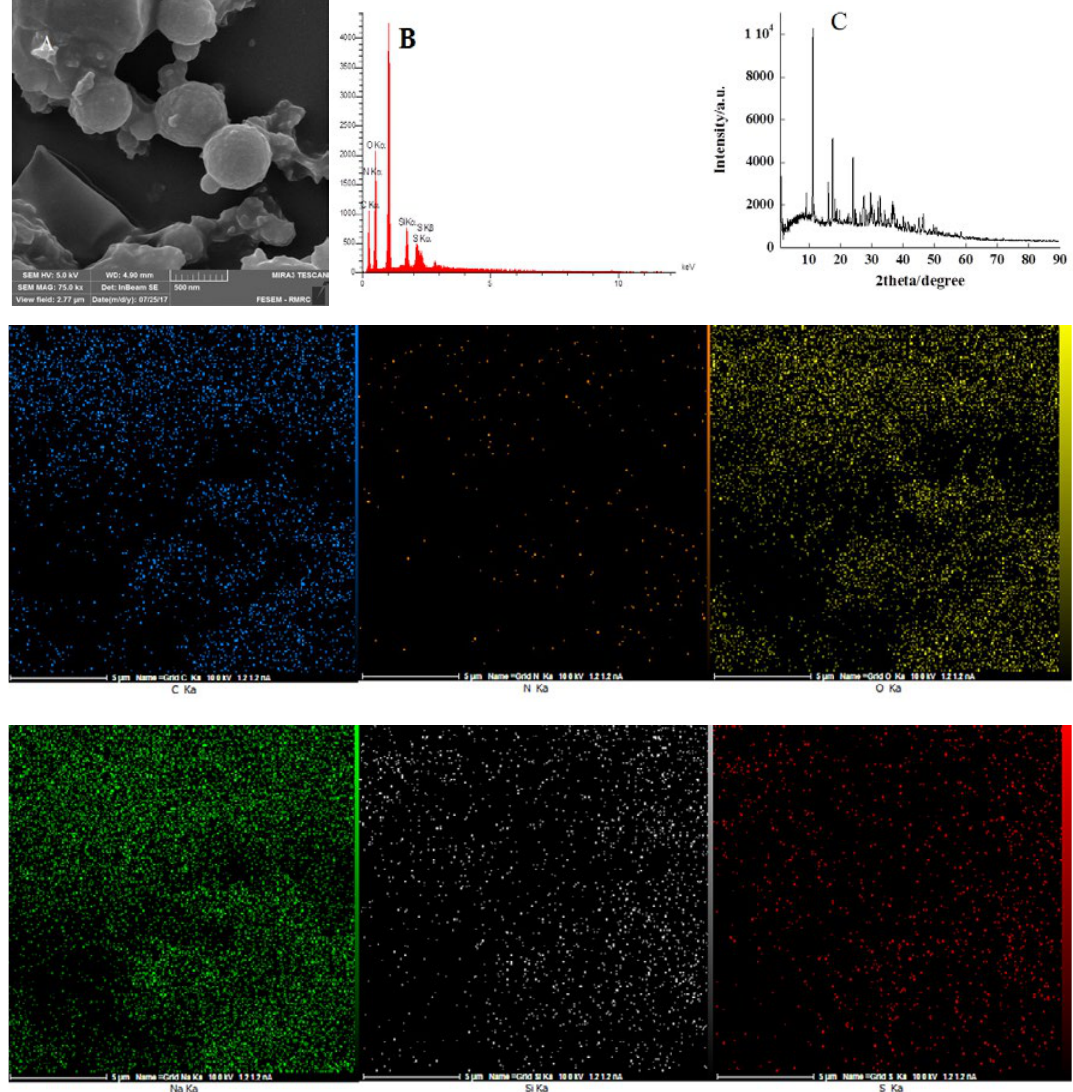
Fig. 1. (A) FE-SEM images of GQDs-N-S, (B) EDAX spectrum, (C) XRD spectra of GQDs-N-S, and (D) elemental mapping of